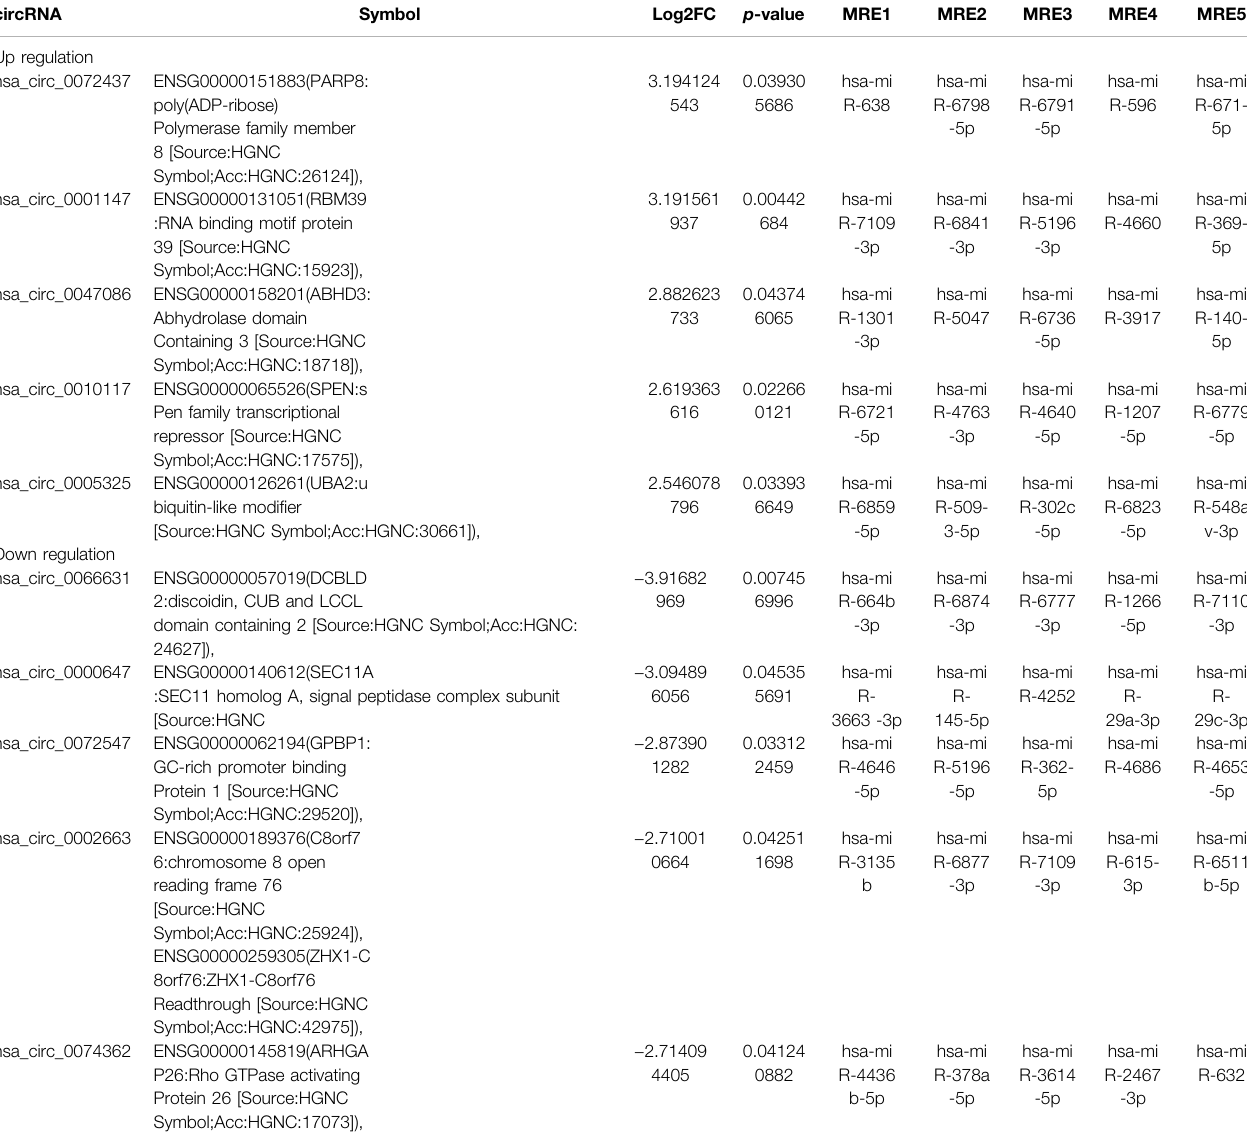
TABLE 3 | Comparison of hepatic fi brosis(HF) versus the control for the top 5 up-regulated and 5 down-regulated expression of circRNAs(FC ≥ 2.0, p < 0.05) sorted by their FC. circRNA Symbol Log2FC p -value